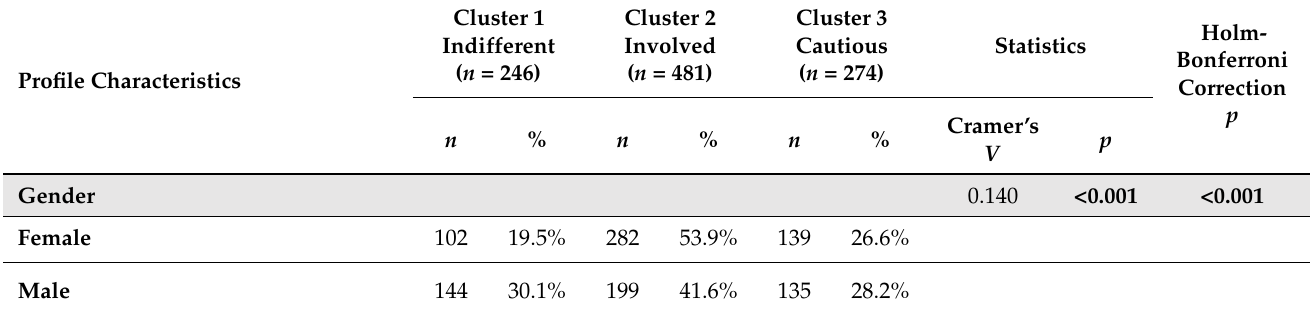
Table 2. Socio-demographic characteristics of people falling into the different clusters.